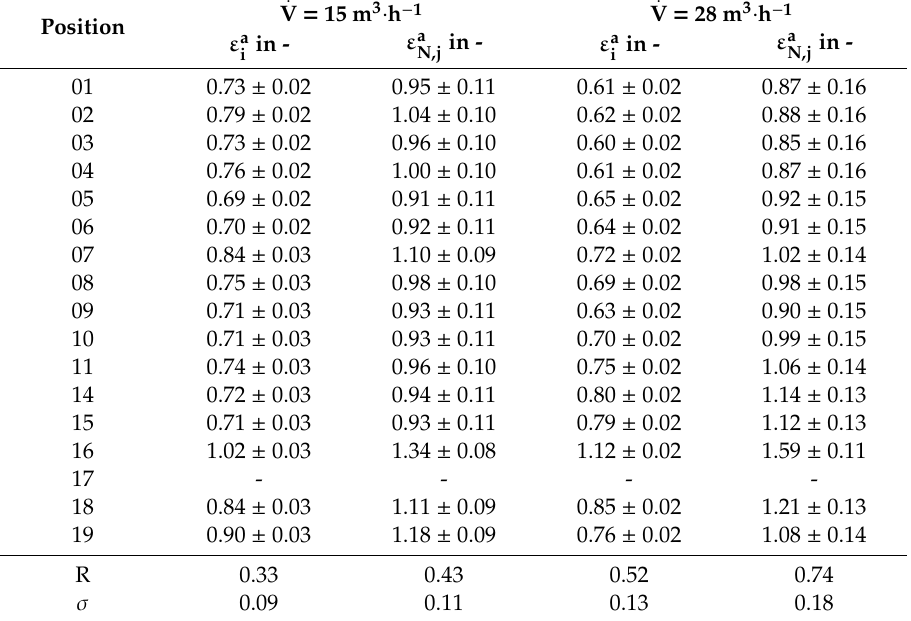
Table A1. Local air exchange at una ff ected (isothermal) supply air conditions.